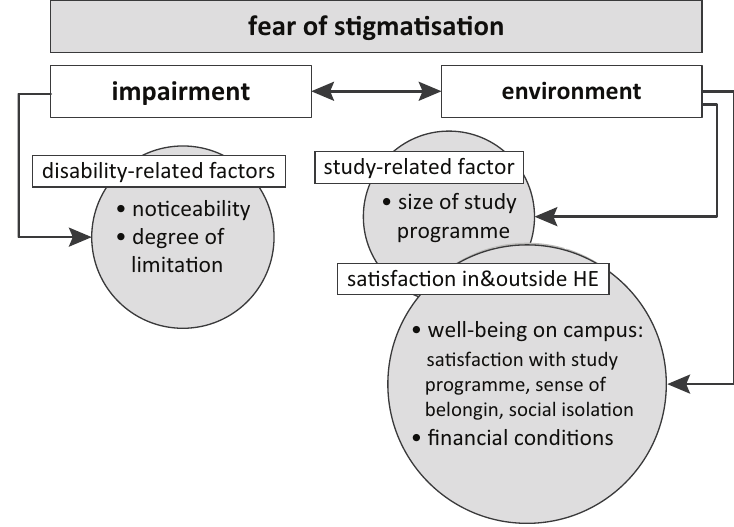
Figure 1. Determinants of fear of stigmatisation associated with the reluctance to seek